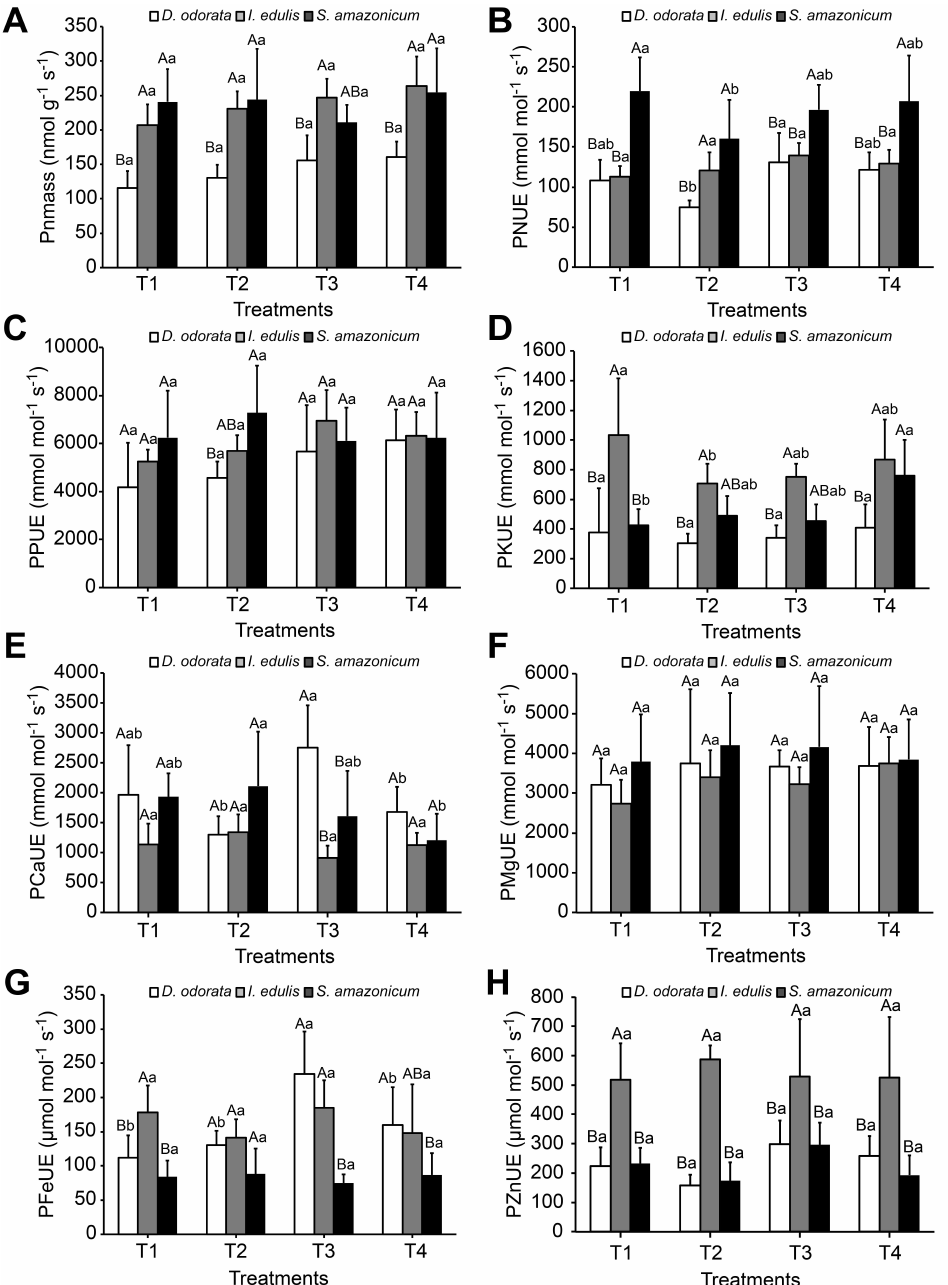
Figure 4. Net photosynthetic rate per unit mass ( P nmass ) ( A ) and the photosynthetic nutrient use efficiencies for ( B ) nitrogen (PNUE); ( C ) phosphorus (PPUE); ( D ) potassium (PKUE); ( E ) calcium (PCaUE); ( F ) magnesium (PMgUE); ( G ) iron (PFeUE) and ( H ) zinc (PZnUE) in all of the treatments. Mean of six samples ( ˘ SD); mean values followed by the same letters did not differ between the treatments at p ď 0.05 based on Duncan’s test. Uppercase letters compare the three species within the same fertilization treatment, and lowercase letters compare different fertilization treatments for each